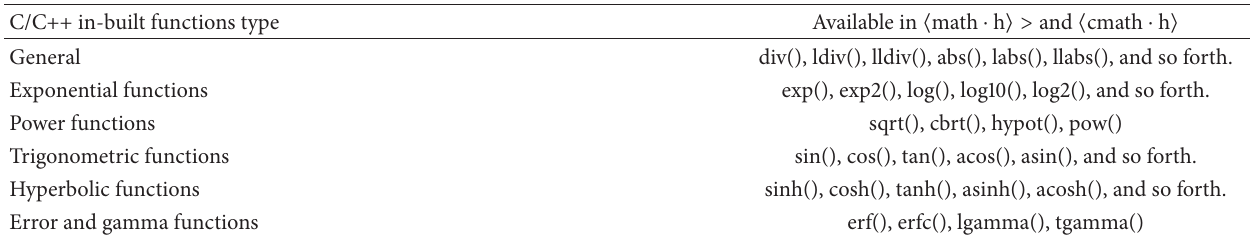
Table 1: Representative list of standard arithmetic functions in